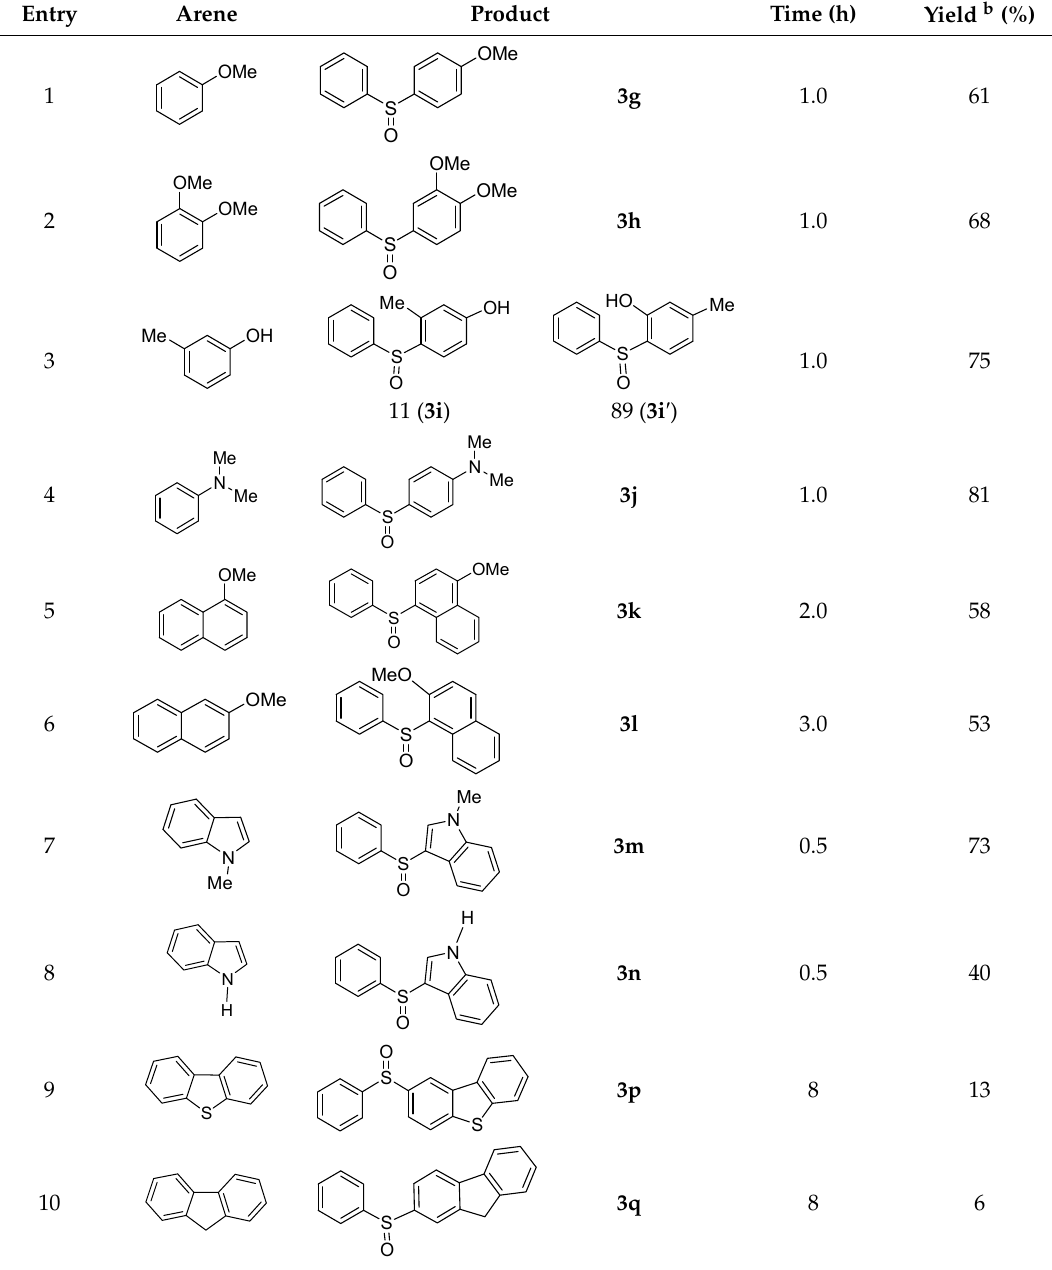
Yield b Yield b Yield b